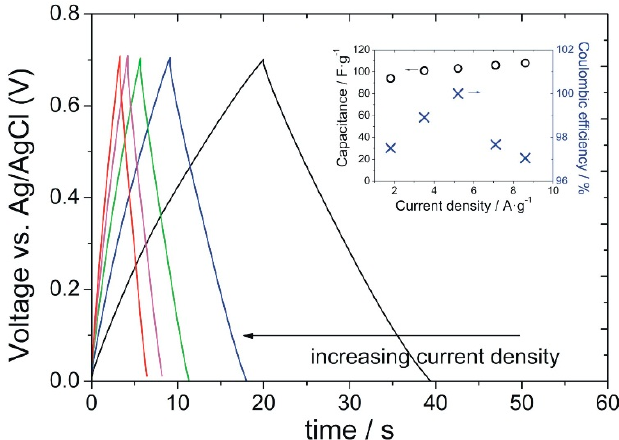
Figure 5. Specific capacitance of bare GNWs and MnO 2 /GNWs samples without (room T) and with annealing at different temperatures versus the scan rate.